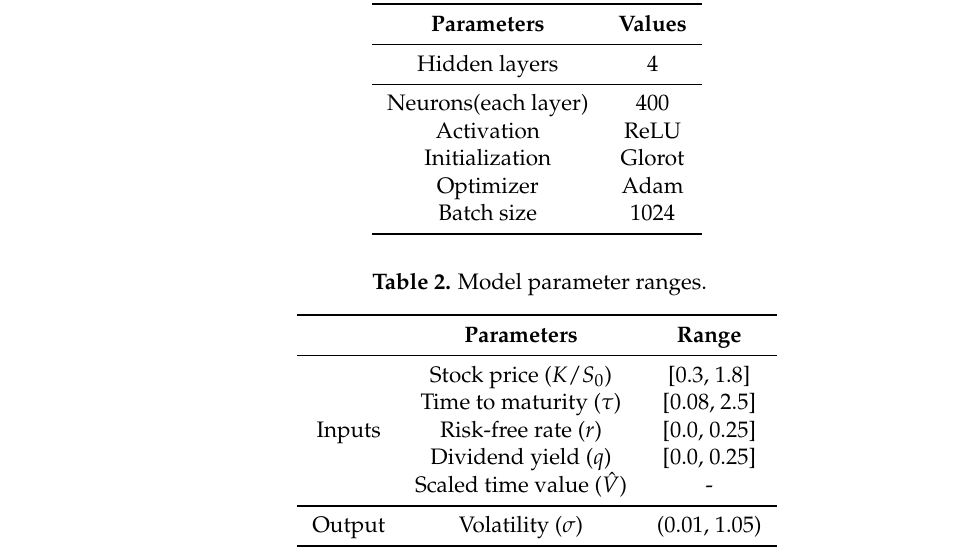
Table 1. Artificial neural network (ANN) hyper-parameters.